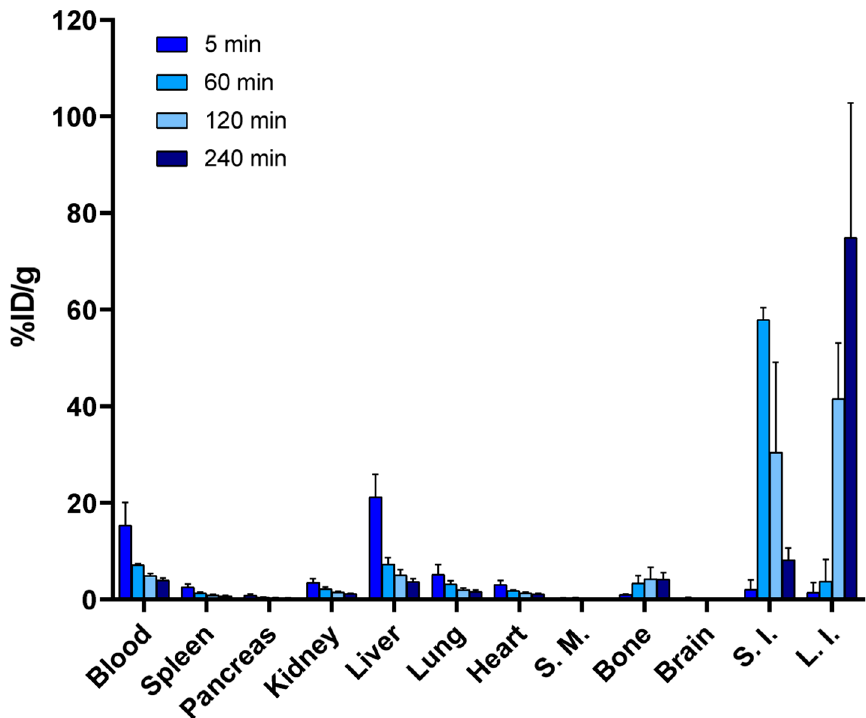
Figure 5. Biodistribution of radioactivity after the intravenous administration of [ 18 F]fluoroalbumin. ([ 18 F] 10 , n = 5) demonstrating a prolonged residence time of radioactivity in whole blood and reduced bone accumulation, indicating resistance to defluorination in vivo. (S.M.—skeletal muscle; bone—tibia; S.I.—small intestine; L.I.—large intestine).